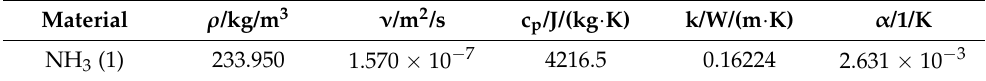
Table 4. Fluid properties of supercritical ammonia at 426.9 ◦ C as obtained from NIST database [23]. Material